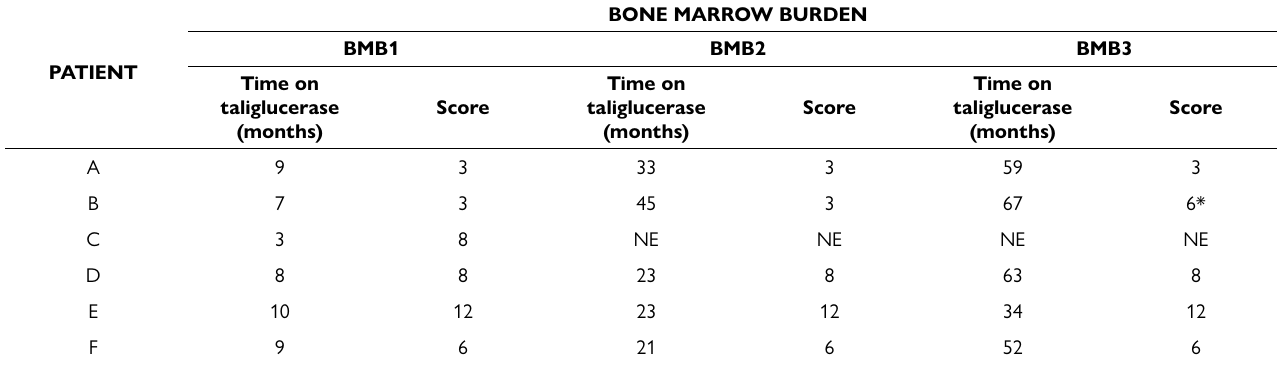
Table 5. Bone Marrow Burden (BMB) score measured during first year of ERT with taliglucerase alfa and every 2 years thereafter.